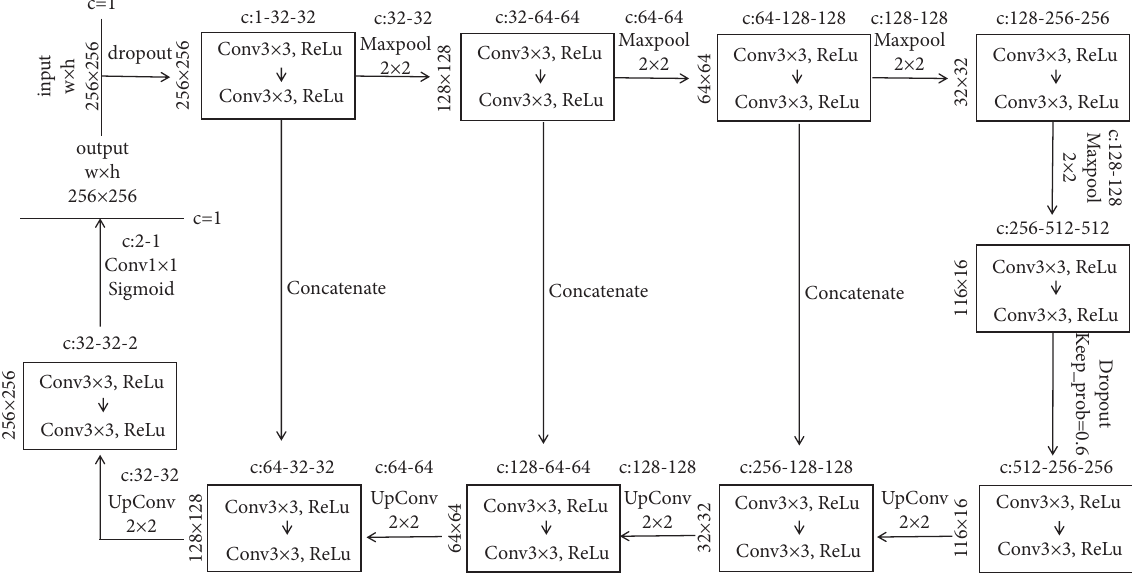
Figure 3: Improved overall U-NET